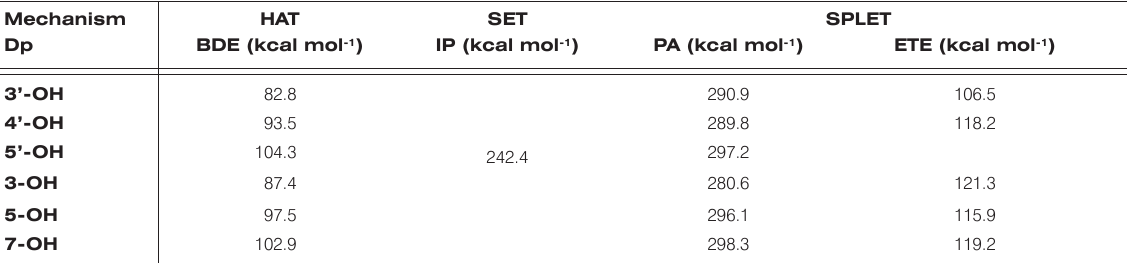
Table 3. Calculated parameters of the three possible radical-scavenging mechanisms for the malvidin radicals (HF/6-31G level) (ROHF/6- 31+(2d,p) level). Mechanism